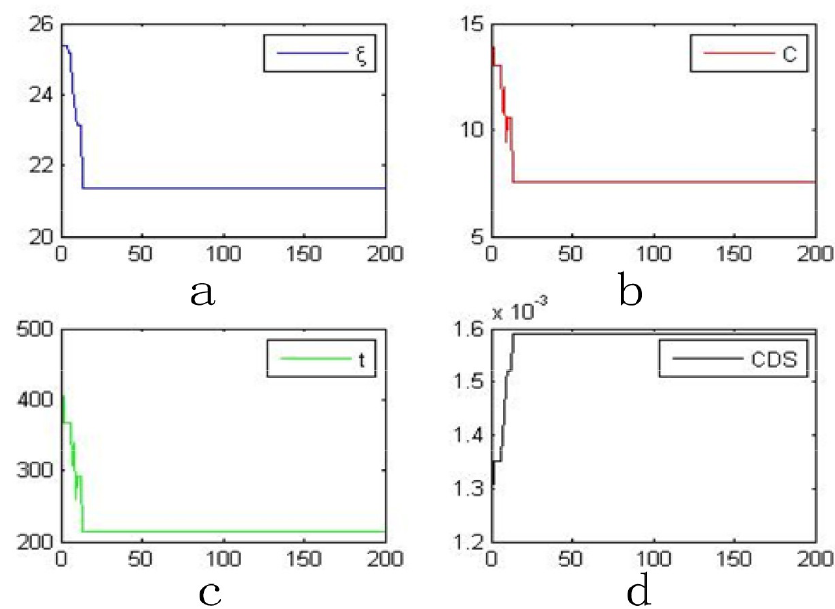
Figure 5. Parameter simulation results